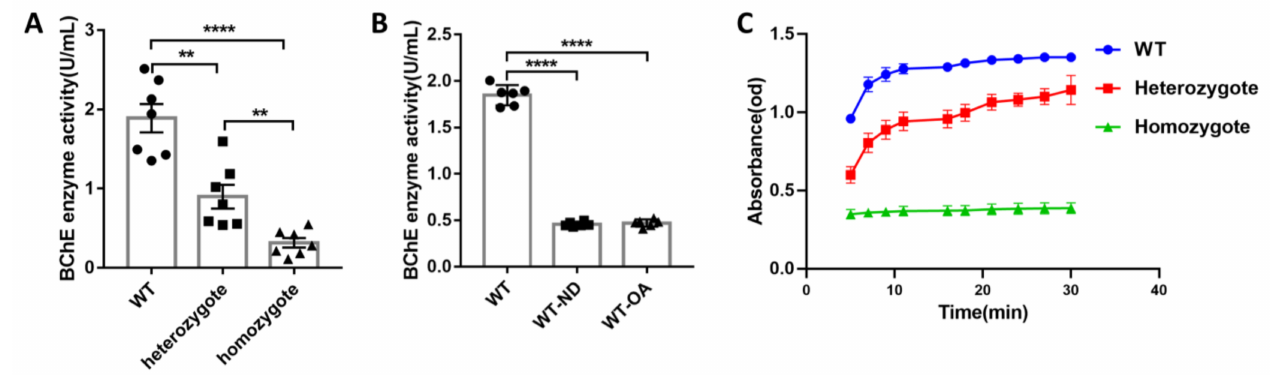
Figure 1. Butyrylcholinesterase (BChE) knockout (KO) and ( R )-bambuterol administration inhibited the activity of serum BChE enzyme in mice. ( A ) Serum BChE enzyme activity in wild-type (WT) mice and BChE KO mice. ( B ) Serum BChE enzyme activity in WT and oral or nasal administration (R)-bambuterol WT mice. ( C ) Enzymatic reaction rate curve of BChE measured using Ellman test. Data in ( A , B ) were shown as mean ± SEM. n = 7–9 mice per group. ** p < 0.01; **** p < 0.0001, one-way ANOVA followed by Tukey’s post hoc test (for A , B